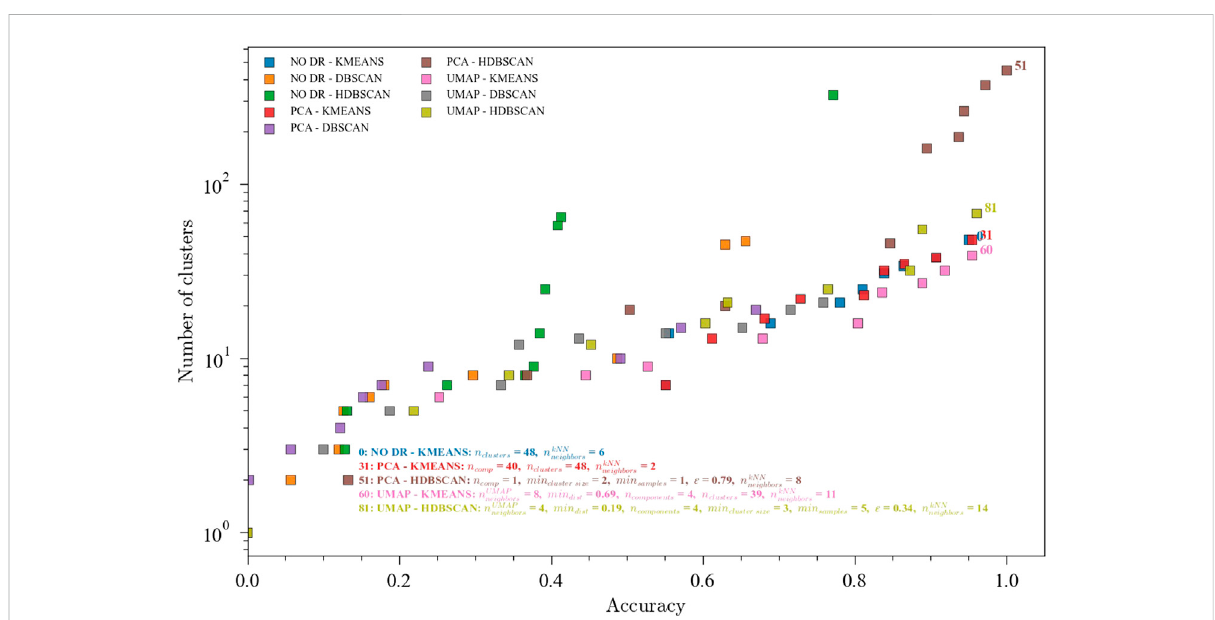
FIGURE 5 Paretofrontsforthemulti-objective(accuracy andnumberofclusters)optimizationoftheensembles.The hyperparametersfortheaccuracies above0.70areshown.DatafromtheTennesseeEastmanProcessdatasetwithfaultsTEP01,TEP04,TEP07,TEP08,TEP10,andTEP13.Ensembles:(0) NO DR-KMEANS, n clusters (cid:1) 48, n kNN neighbors (cid:1) 6; (20) NO DR-HDBSCAN, min cluster size (cid:1) 2, min samples (cid:1) 1, ε (cid:1) 0 . 91, n kNN neighbors (cid:1) 6; (31) PCA-KMEANS, n components (cid:1) 40, n clusters (cid:1) 48, n kNN neighbors (cid:1) 2; (51) PCA-HDBSCAN, n components (cid:1) 1, min cluster size (cid:1) 2, min samples (cid:1) 1, ε (cid:1) 0 . 79, n kNN neighbors (cid:1) 8; (60) UMAP-KMEANS, n UMAP neighbors (cid:1) 8, min dist (cid:1) 0 . 69, n components (cid:1) 4, n clusters (cid:1) 39, n kNN neighbors (cid:1) 11; (81) UMAP-HDBSCAN, n UMAP neighbors (cid:1) 4, min dist (cid:1) 0 . 19, n